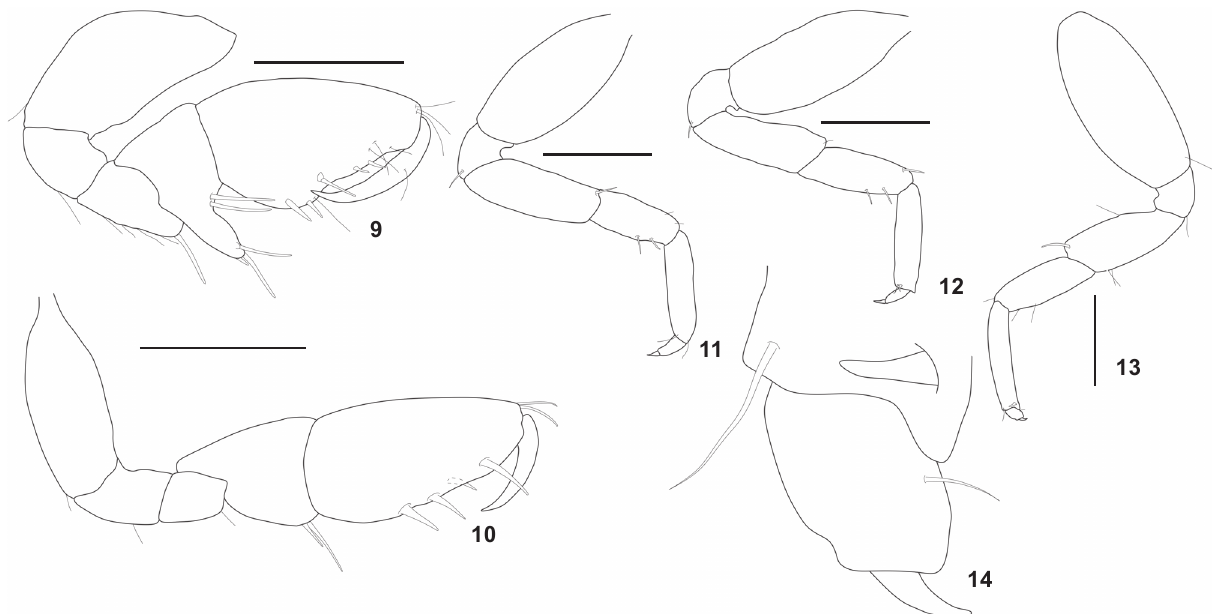
Figures 9-14. Bogidiella totakura sp. nov. , holotype, female: (9) gnathopod 1; (10) gnathopod 2; (11) pereopod 3; (12) pereopod 4; (13) pereopod 5; (14) pereopod 5 detail, propodus and dactylus. Scale bars: 0.1